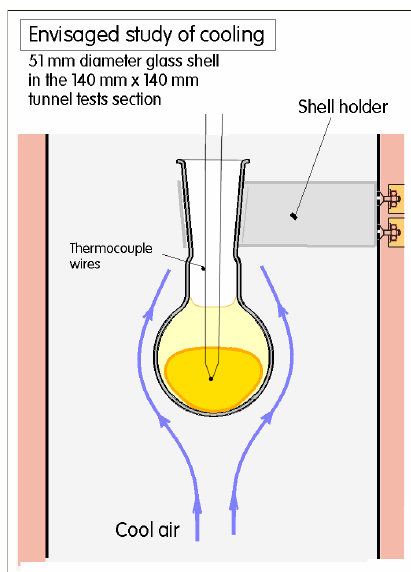
Fig. 12. Proposed configuration of the planned experiments. The heating/cooling fluid (air) flows vertically past the scaled- up model of microcapsule. The spherical shell is actually a commercially available glass vessel (flask) attached to the holder at the vessel neck.